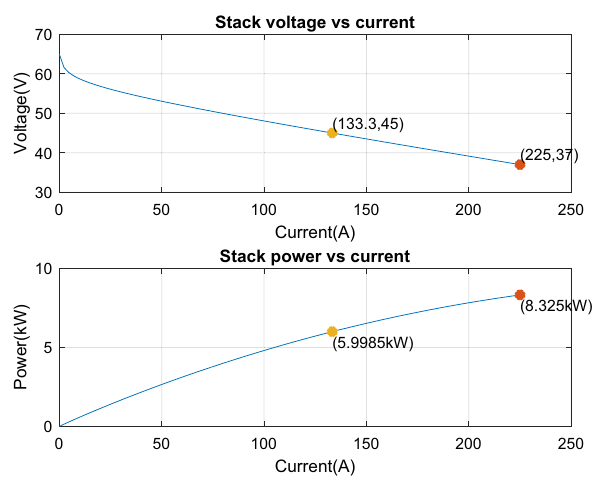
Fig. 3 I–V and P–V characteristics graphs of the proposed Fuel